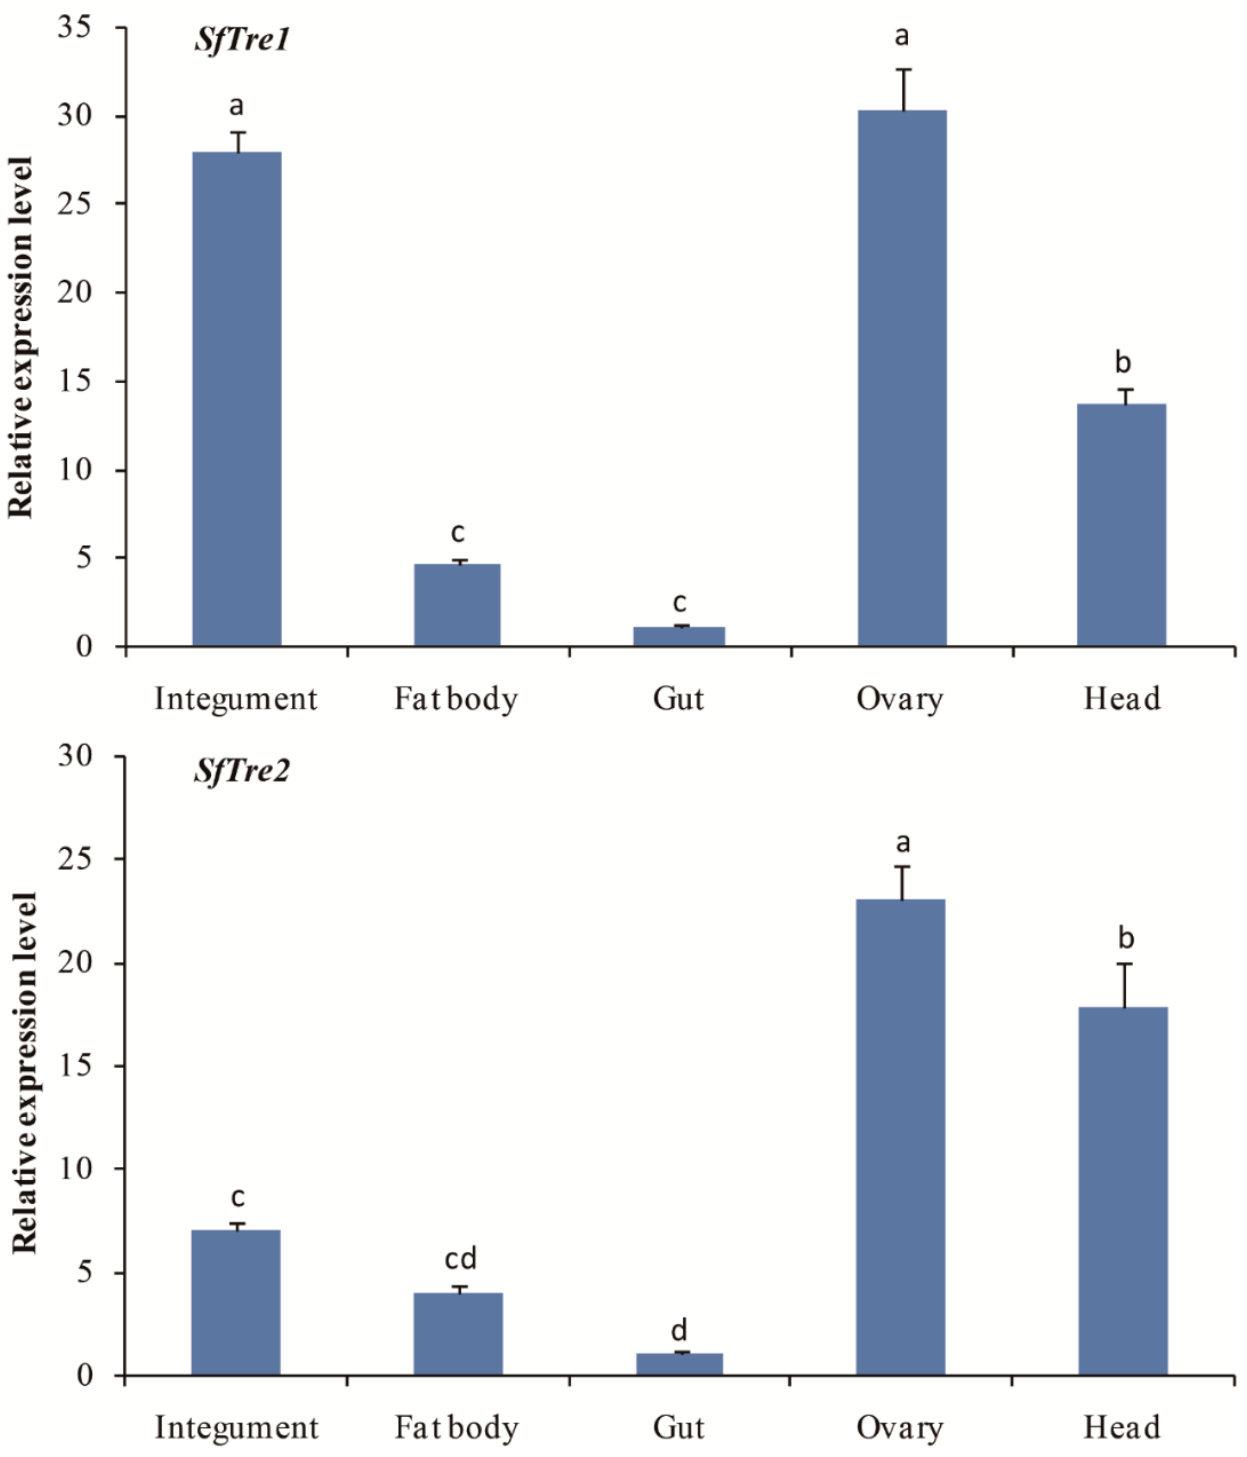
Figure 5. Expression profiles of SfTre1 and SfTre2 in different tissues of S. furcifera . Sf18S was used as an internal reference gene. The relative expression level was calculated based on the value of the lowest expression, which was arbitrarily set to 1. Data are presented as means ± standard error of three biological replicates. Different lowercase letters above the bars indicate significant differences ( p < 0.05, Duncan’s multiple range test in one-way analysis of variance).